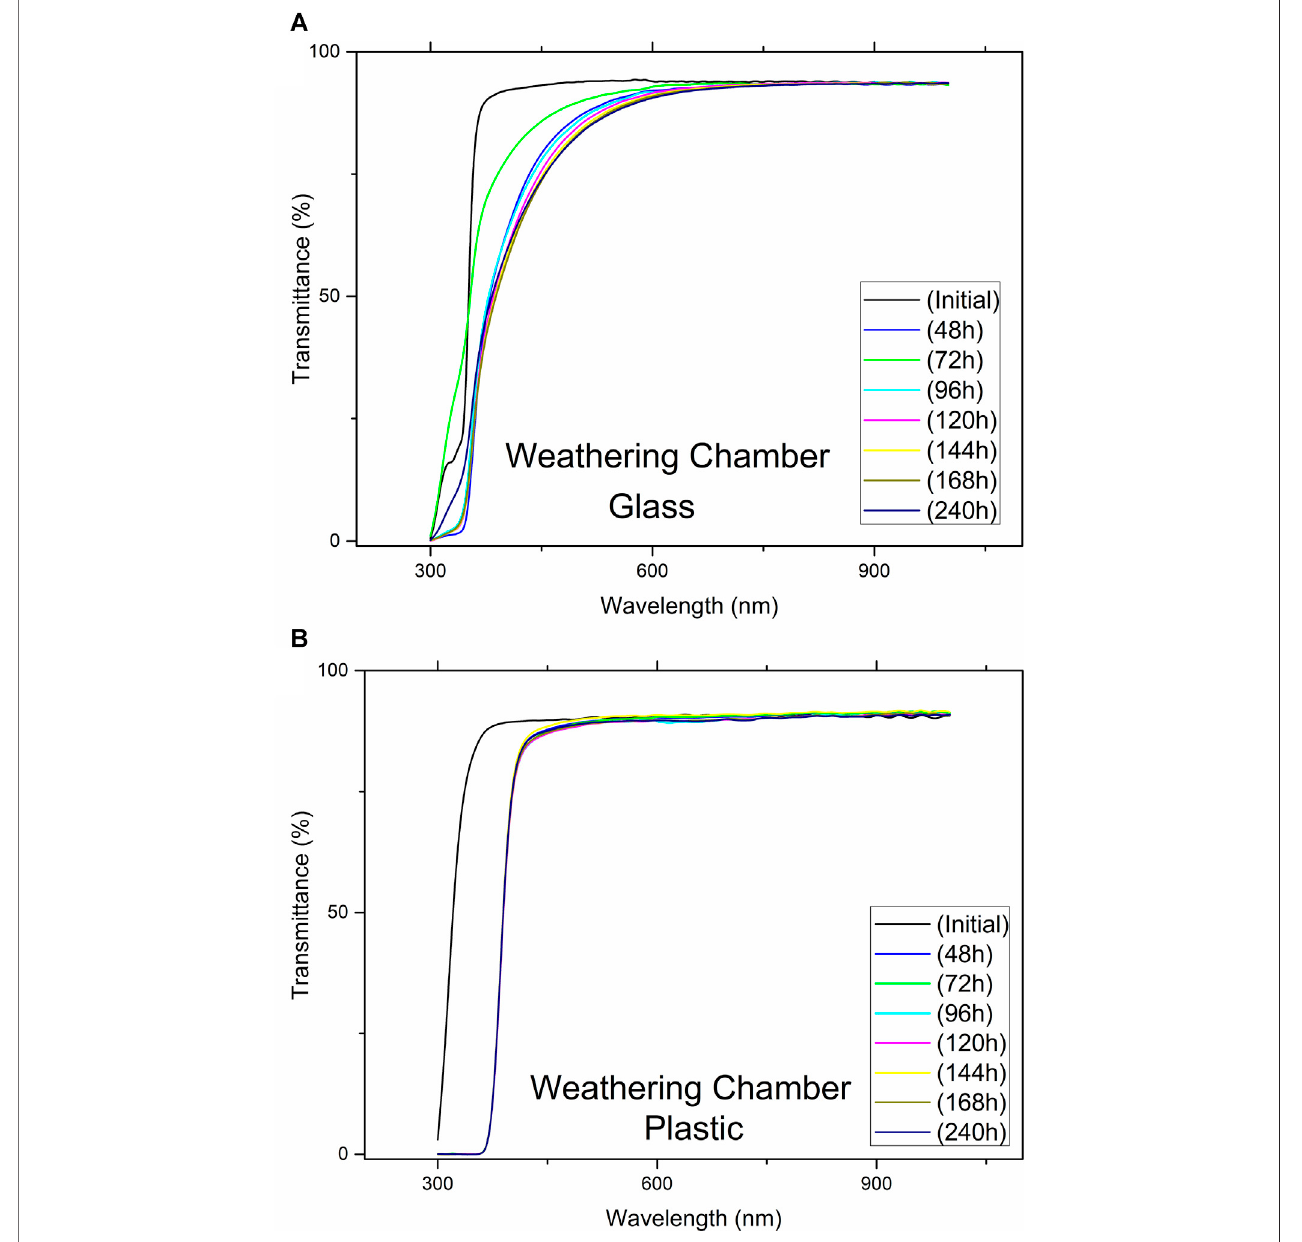
FIGURE 8 | Evolution of the transmittance vs. time for ISOS-LT-1 for both encapsulations (glass (A) and plastic (B) , respectively).